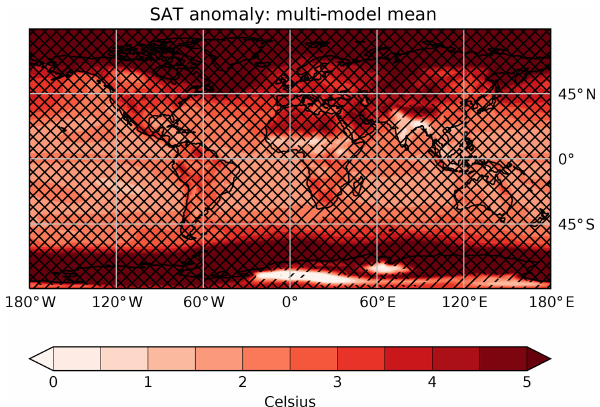
Figure 2. Plio Core –PI Ctrl SAT multi-model mean anomaly. Grid boxes where at least 80% of the models agree on the sign of the change are marked “ / ”. Grid boxes where the ratio of the multi- model mean SAT change to the PI Ctrl intermodel standard devia- tion is greater than 1 are marked “ \ ”. Grid boxes where both these conditions are satisfied show a robust